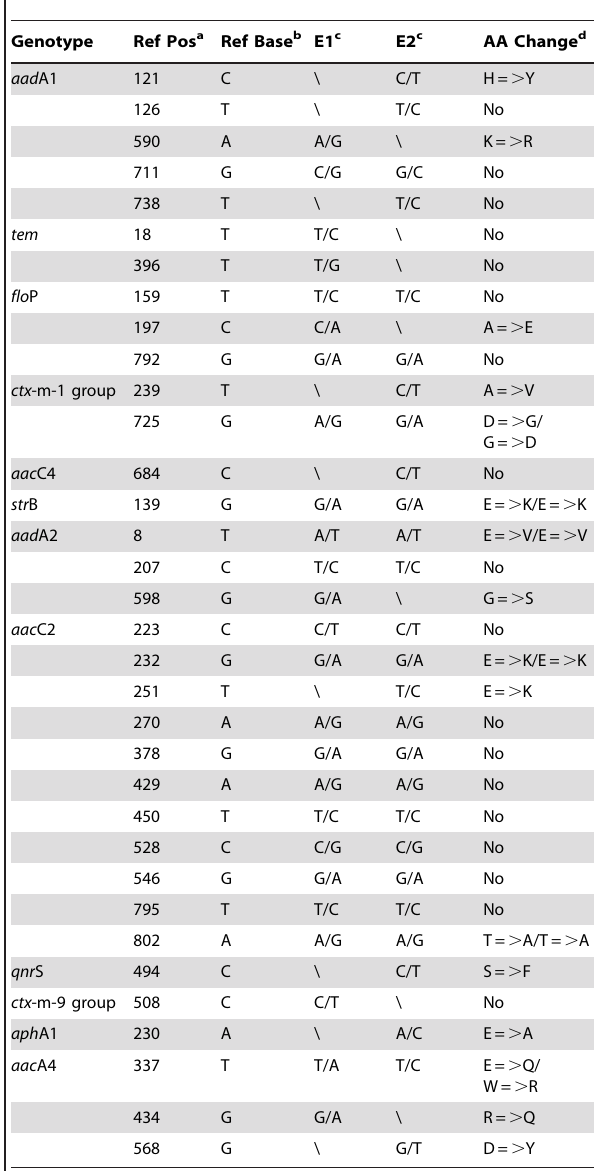
Table 2. The SNPs of resistance genotypes emerging in the two samples.